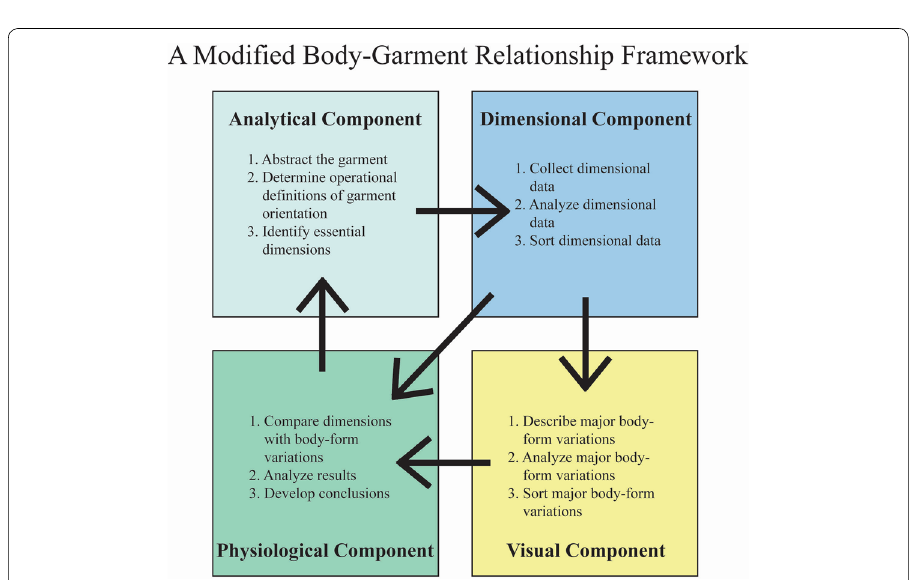
Fig. 3 The modified body–garment relationship framework used in this study. Start from the analytical component and work in a clockwise